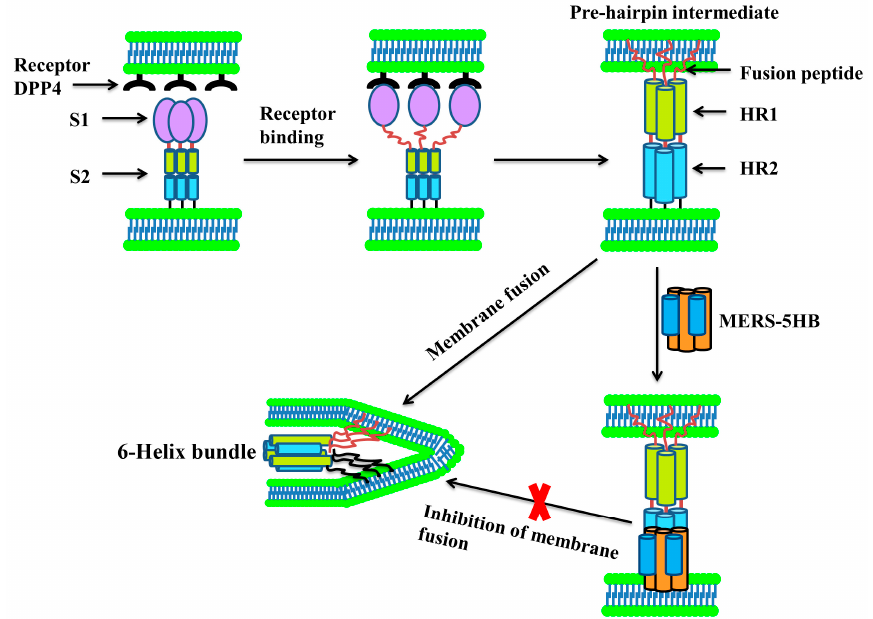
Figure 6. Model of MERS-5HB for inhibition of MERS-CoV entry. One of the key steps for MERS-CoV entry into host cells is the membrane fusion. MERS-5HB, lacking one HR2, could bind to the native viral HR2 in S2 to block the formation of the fusion core which is the central structure during the viral and host membrane fusion process.